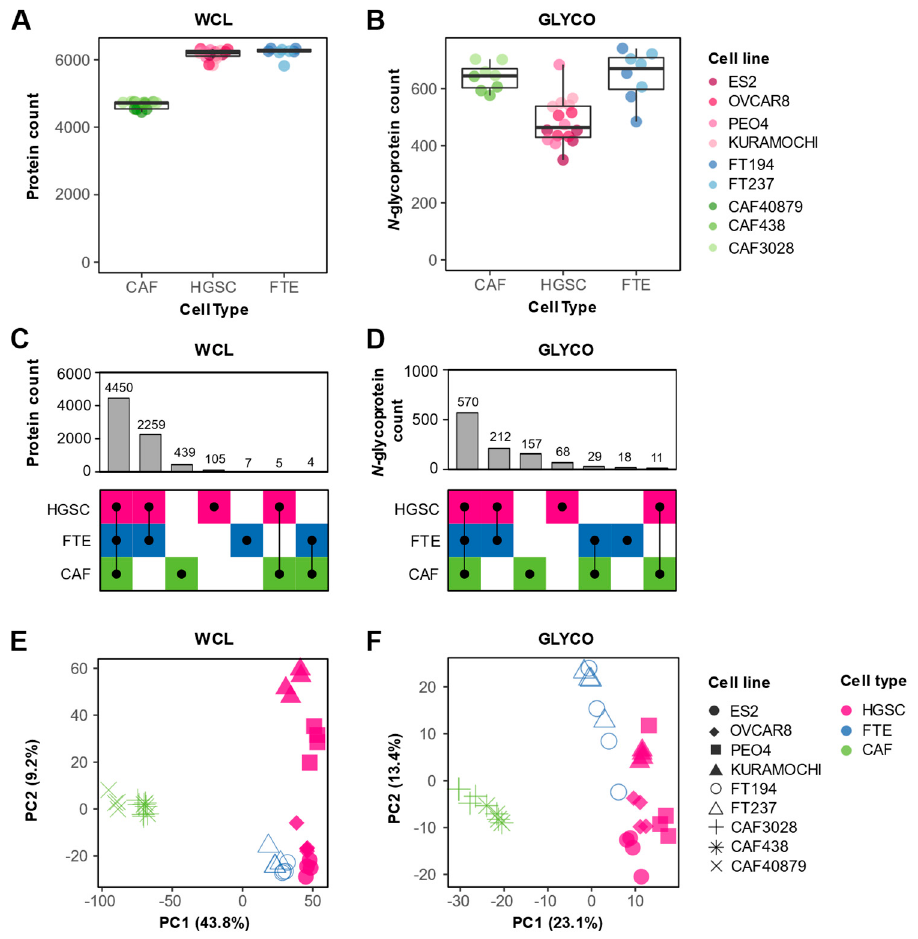
Figure 2. Proteomic cell type heterogeneity. ( A , B ) Box plots showing number of proteins detected by cell type in ( A ) WCL and ( B ) GLYCO fractions. Dots represent number of proteins detected in each processing replicate ( n = 4) and are colored based on cell line. ( C , D ) UpSet plots depicting protein detection differences between CAFs, HGSC, and FTE cells in ( C ) WCL and ( D ) GLYCO fractions. ( E , F ) Principal component analysis of ( E ) WCL and ( F ) GLYCO proteomic data. Each point represents a cell line-processing replicate ( n = 4), and the shape indicates respective cell line. Color is used to denote cell type.